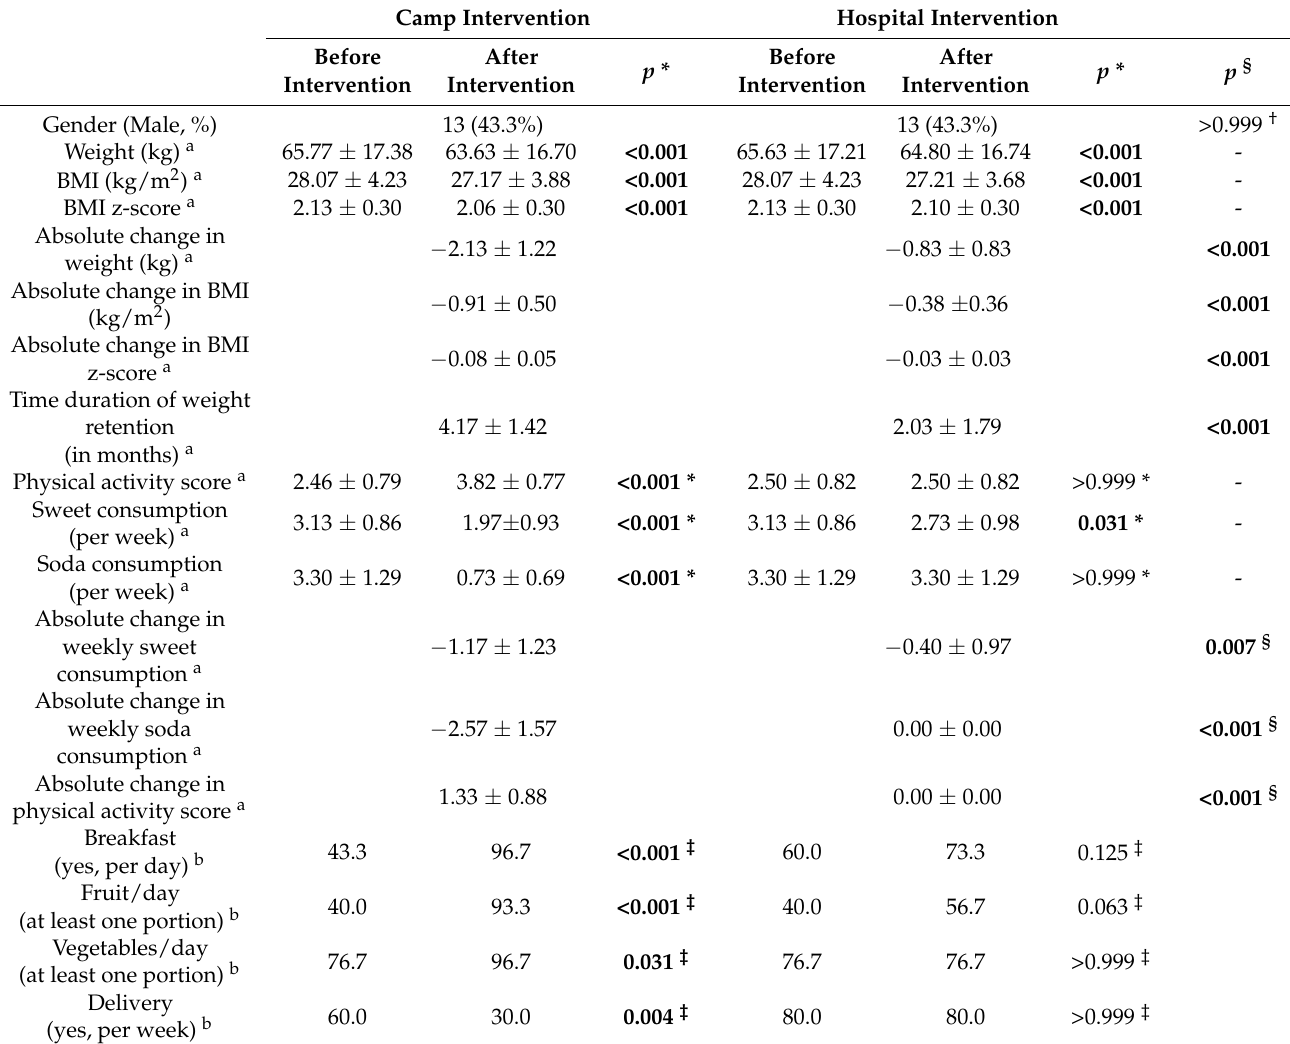
Table 2. Comparison of anthropometric parameters as an absolute change in diet habits and physical activity between camp and hospital intervention